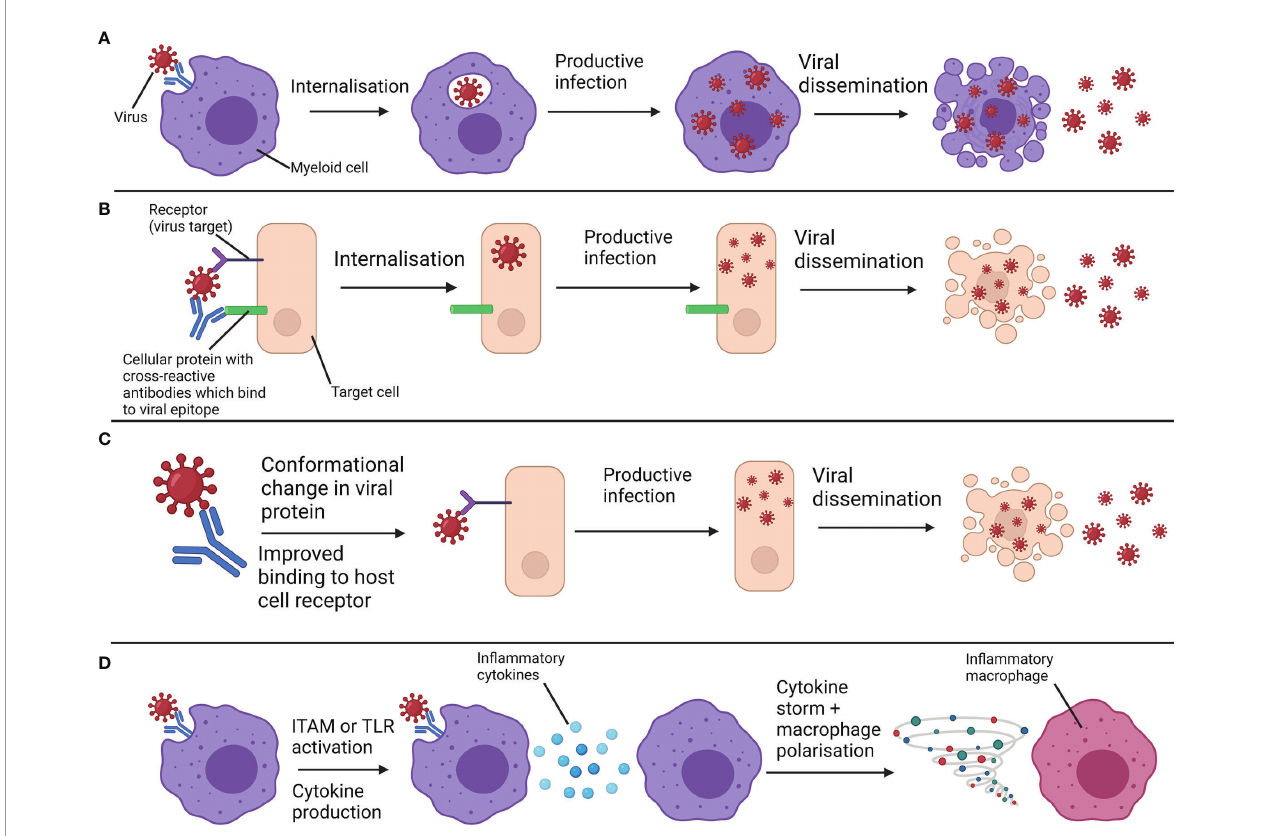
FIGURE 2 | Overview of antibody-dependent enhancement (ADE) and antibody-enhanced disease (AED). (A) Non-neutralising antibodies or sub-neutralising antibody concentrations bind to viruses and interact with Fc receptors on myeloid cells. This facilitates the internalisation of viruses. Viruses that can productively infect myeloid cells can proliferate and spread following their uptake, enhancing infection. This is a form of ADE. (B) Cross-reactive antibodies bind to both virus and host cell components, bringing viruses in close contact with their receptor. Receptor-mediated uptake and enhanced infection follows. This is another form of ADE. (C) Antibodies against a particular epitope drive a conformational change in a viral protein which enhances infection through improved binding to the host cell receptor. This is another form of ADE. (D) Antibodies bound to virus interact with Fc receptors on myeloid cells and either activate immunoreceptor tyrosine-based activation motifs (ITAMs) associated with these receptors, or facilitate viral uptake and subsequent activation of endosomal toll-like receptors (TLRs). Through either of these mechanisms, in fl ammatory cytokines and chemokines are produced, exacerbating in fl ammation to a pathogenic extent and polarising myeloid cells towards more in fl ammatory phenotypes. These are forms of AED. Productive infection of myeloid cells is not required for this mechanism. Created with